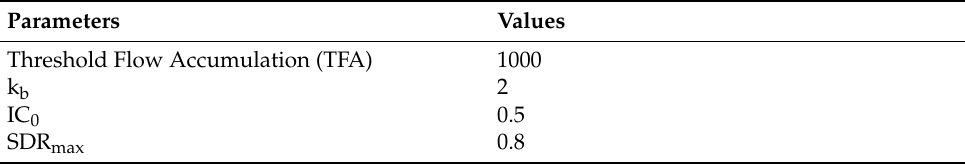
Table 3. Values used for the threshold flow accumulation, k b , IC 0 and SDR max